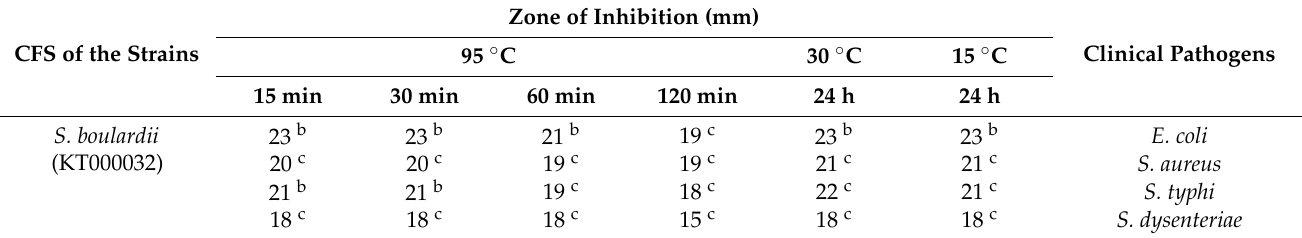
Table 11. Thermostability of S. boulardii strain cell free supernatant (CFS) heated at 90 ◦ C for 15, 30, 60, 120 min and 121 ◦ C for 30 min. Values are expressed as the mean ± standard deviation ( n = 3). Different superscripts (a, b, c, d) represent significantly.